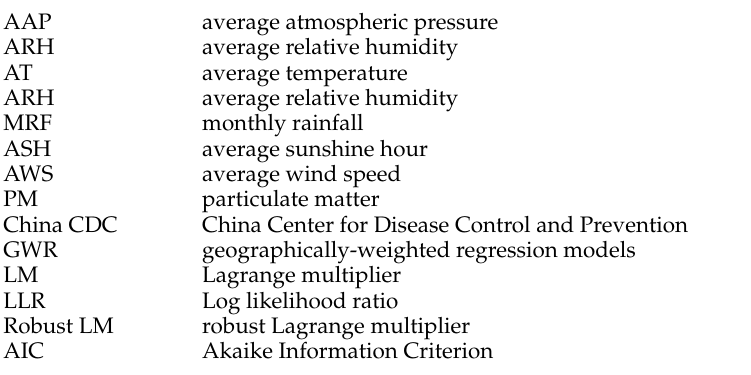
Figure S1. Spatial contiguity weights: rooks and queens, Figure S2. Global Moran’s spatial autocorrelation analysis of scarlet fever in Beijing-2013 and 2014. Table S1. Results of tests to determine specific fixed effects and spatial